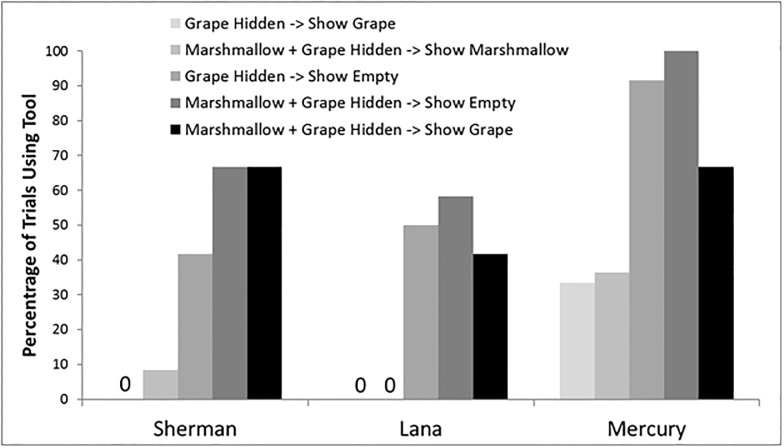
Tool use in Experiment 5.The percentage of trials on which each chimpanzee used the tool to inspect containers in each of the five test conditions in Experiment 5. The two lightest colored bars are trial types in which one would expect little or no use of the tool given that all information about where the best item on that trial was located was already provided. For the three darkest bars, the chimpanzees could not know where the best food item on that trial was located without using the tool.